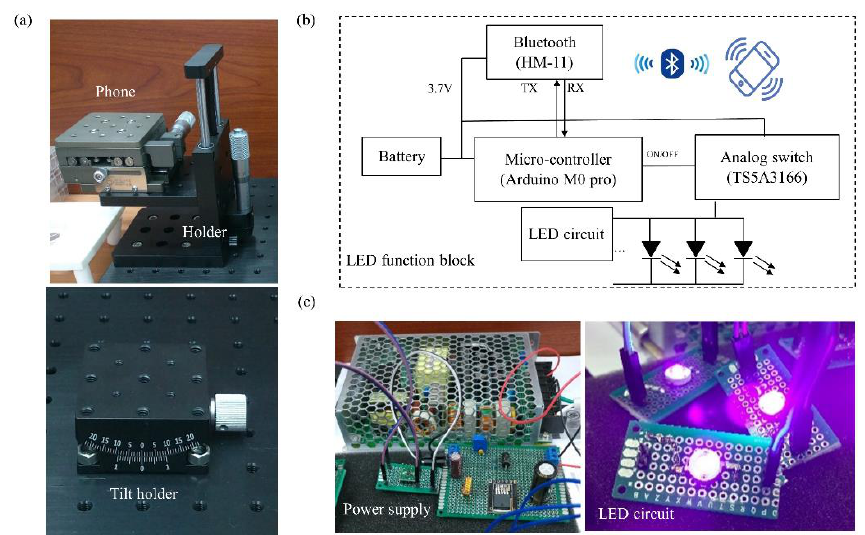
Figure 4. System hardware design for detecting the thickness of a PBA-based HEMA contact lens. ( a ) A stable distance for detecting the thickness of the PBA-based HEMA contact lens was used as the platform with a smartphone (HTC M9+ with a Sony IMX230 photosensitive sensor). ( b ) The schematic illustration of the system hardware configuration of the emission device. ( c ) Photograph of a microcontroller (Arduino M0 Pro, left) powered by a 3.7 V power supply and Bluetooth module (HM-11, right) that could be controlled using a smartphone-triggered LED light and receive the image easily.